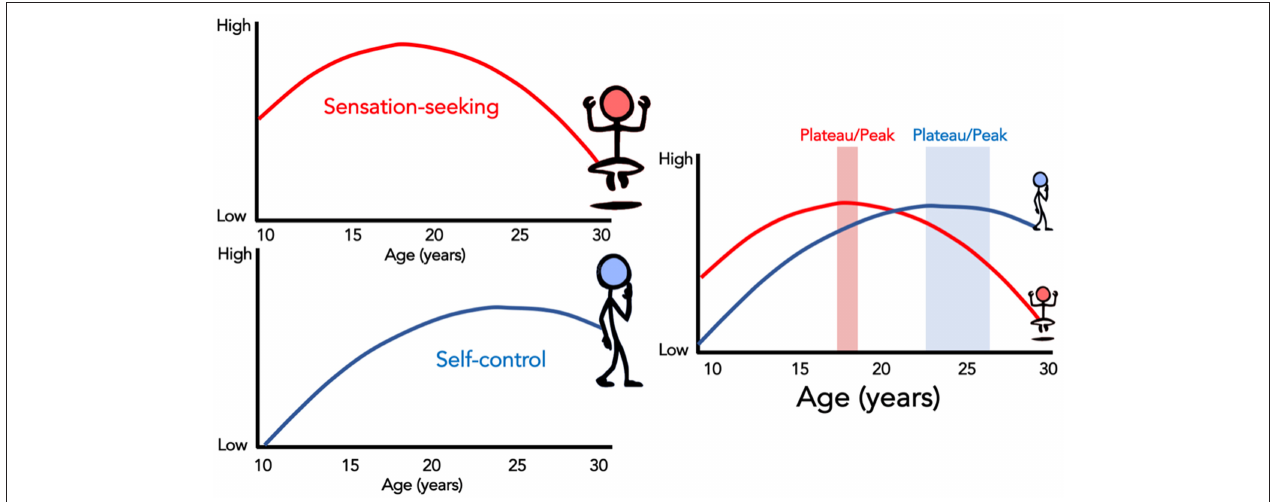
FIGURE 1 | Changes in sensation-seeking (left, top) and self-control (left, bottom) as a function of age (adapted from Steinberg et al., 2017). Both sensation-seeking and self-control were derived from a composite measure including surveys and performance assessments. The chart on the right superimposes the developmental trajectories of sensation-seeking and self-control and shows (light red, light blue) differences in the timing of their respective peaks and